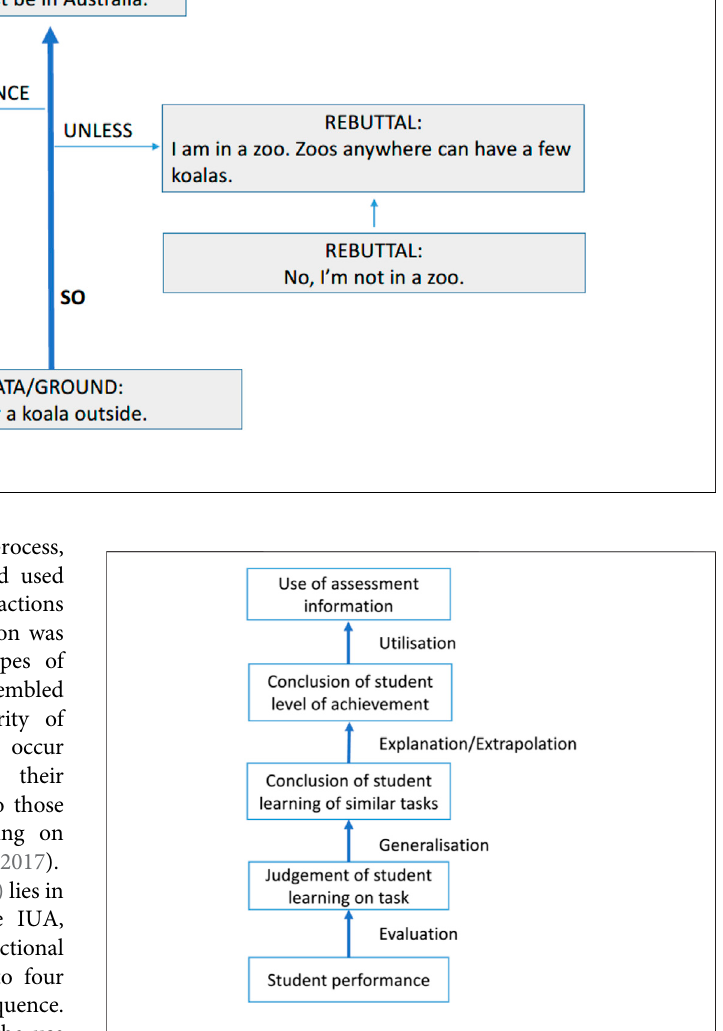
FIGURE 3 | Chain of inferences in